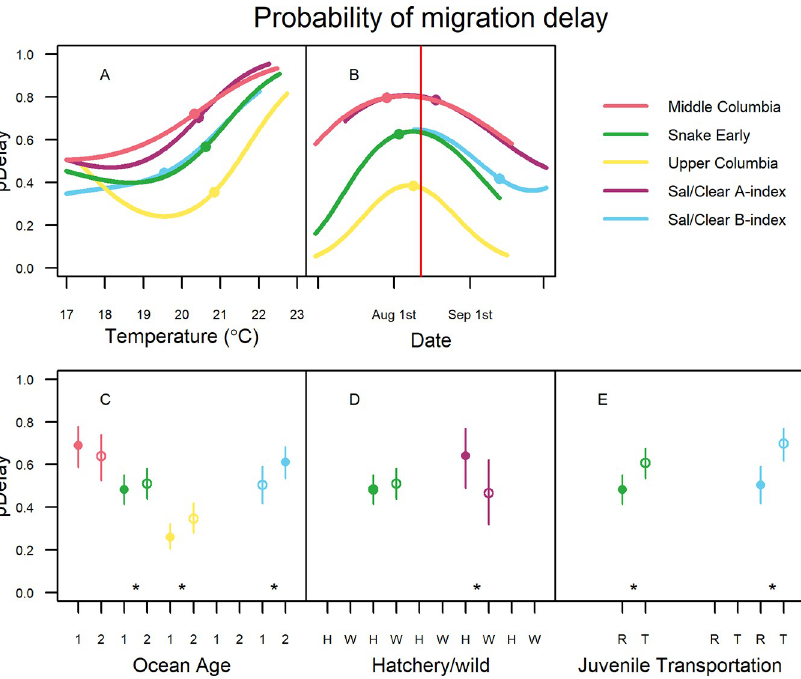
Fig 5. Covariate effects for probability of delay models. All variable effects are shown conditioned on the median or most common value of other variables in the entire dataset. All retained continuous variable effects contributed significantly ( P < 0.05) and are shown for the 95% central extent of variable range for each population group with median values shown by points (A and B). Vertical red line represent date of peak temperatures averaged across study years (B). Significance of categorical variables (C-E) is shown by asterisks ( P < 0.05) and uncertainty is shown by vertical lines. Filled circles in C-E indicate pDelay for the most common value of each categorical variable. R represents river-run (not transported) while T represents transported juveniles